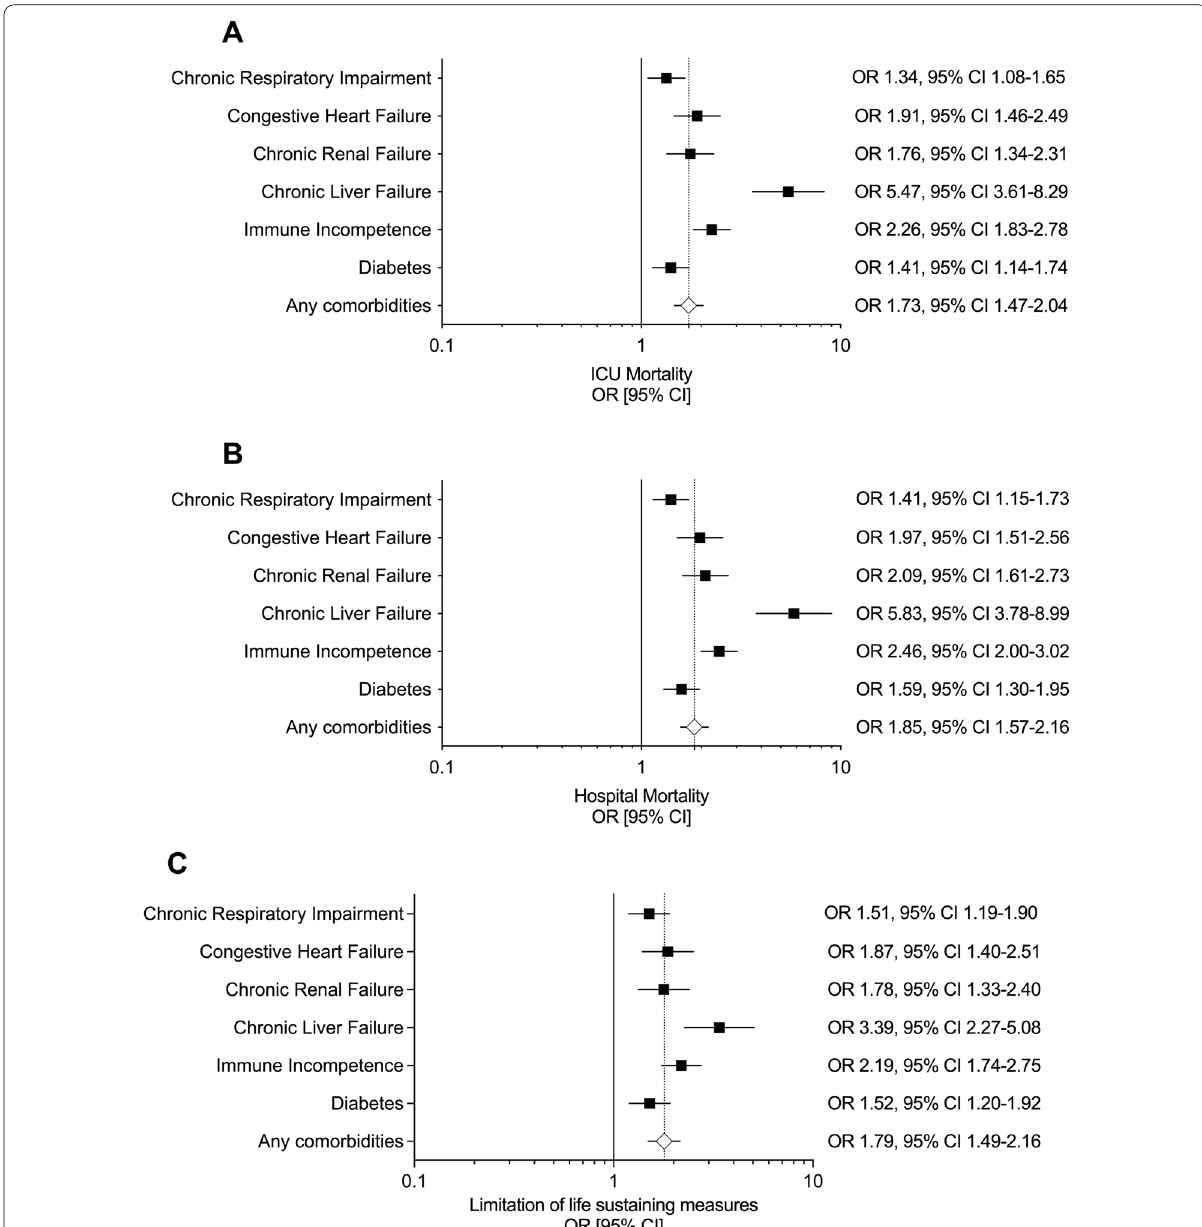
Fig. 2 A ICU mortality, B hospital mortality and C limitation of life-sustaining measures as a function of patients with comorbidities. Unadjusted odds ratio calculated versus patients with no